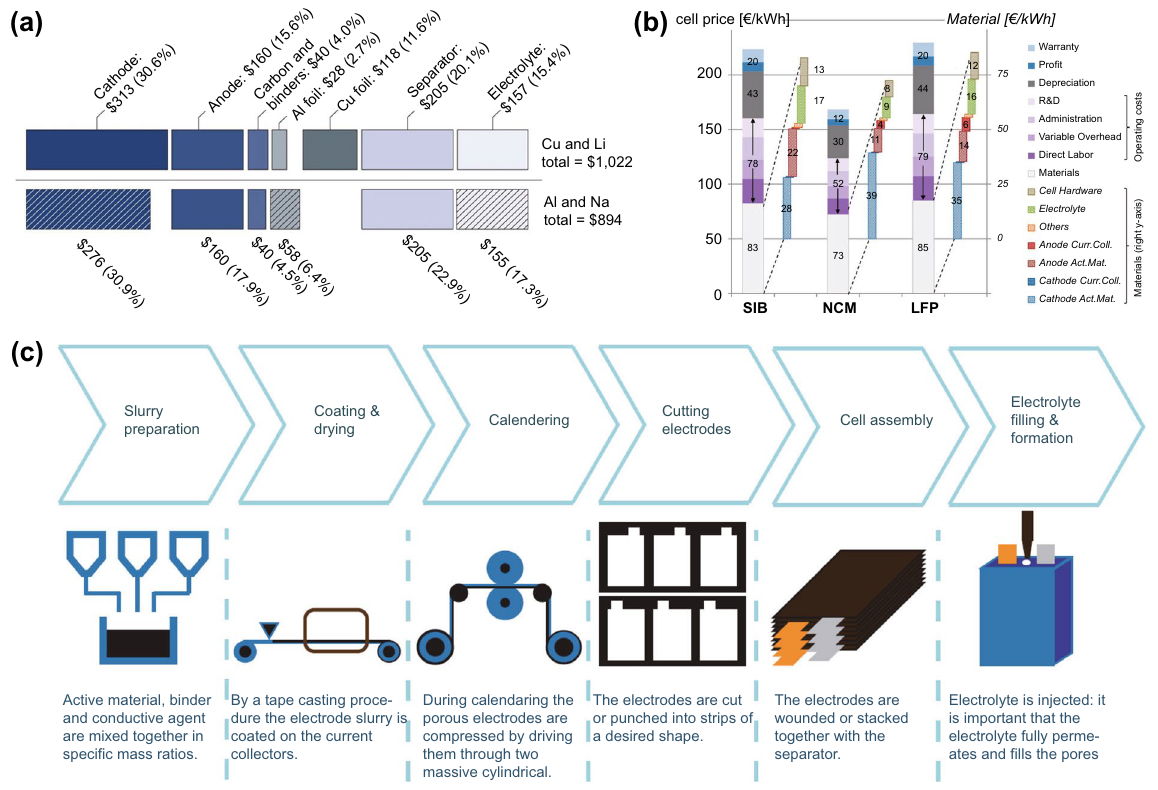
Fig. 19 a Cost comparison of a hypothetical SIB formed from simple replacement of Li and Cu to Na and Al in an LIB [42] . Copyright 2018, Springer Nature. b Cost comparison of an SIB with NCM and LFP LIBs [259] . Creative Commons License (CC BY 4.0). c Typical